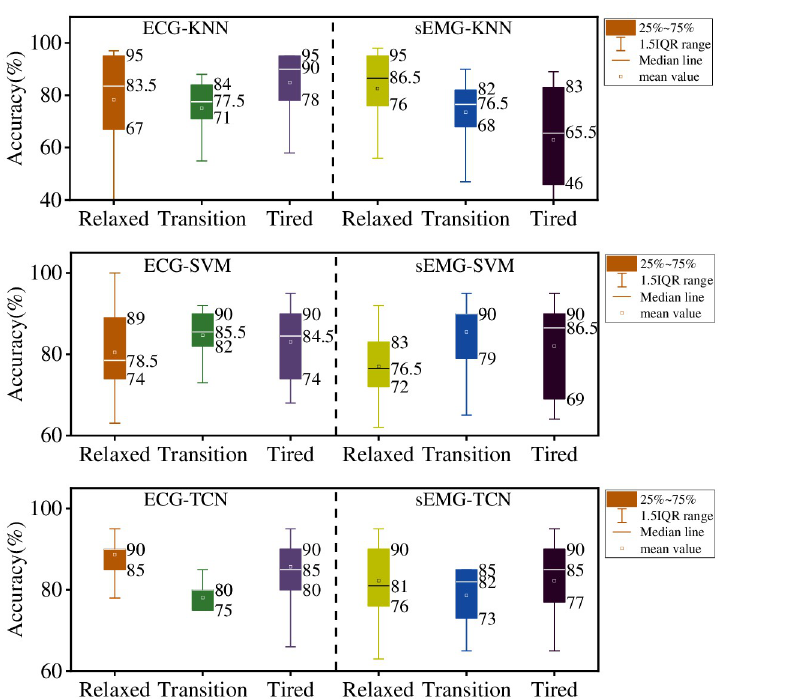
Fig 11. The accuracy statistics of each tester in the models.